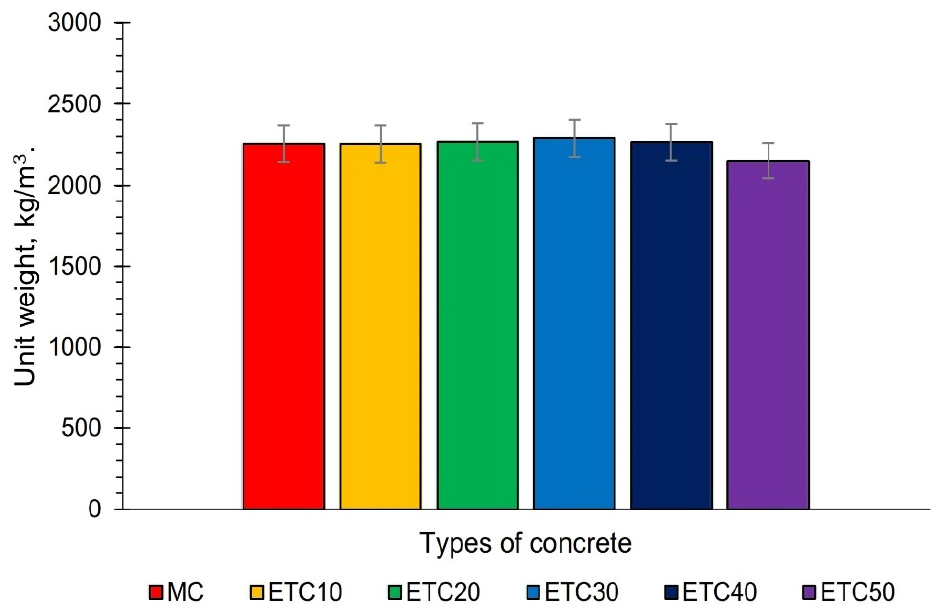
Figure 7. Unit weight of the studied concretes.